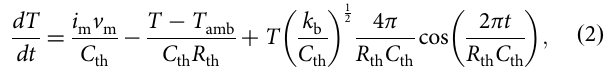
Figure 2a shows the experimental and simulated current – voltage curves. Although there is some mismatch in the NDR-1 region, the model reproduced the experimental data quite well.